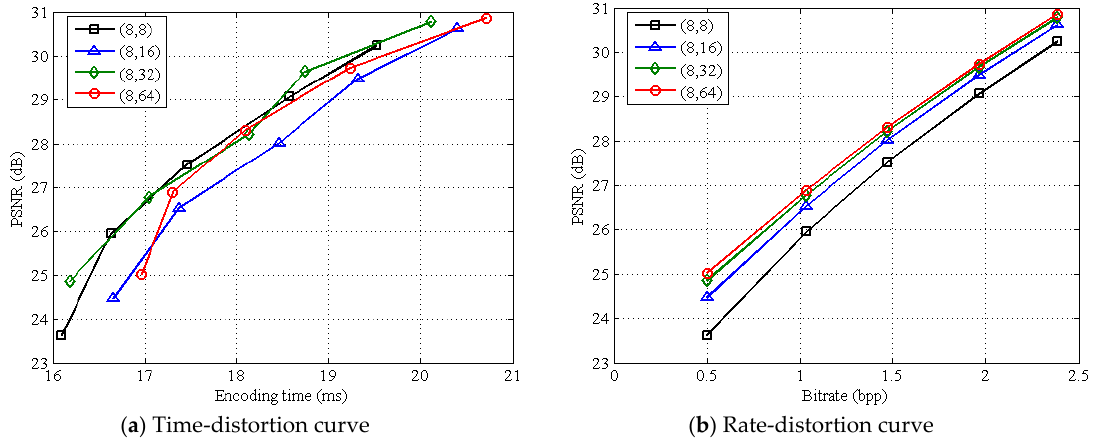
Figure 9. Average time-distortion and rate-distortion curves on test images for LA structures with various block-size pairs.